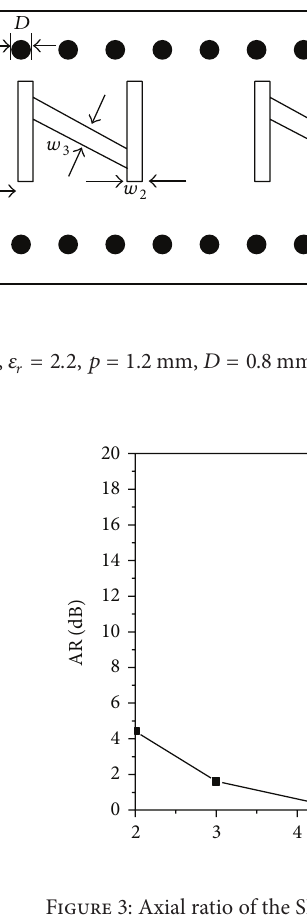
Figure 2: 𝑆 -parameters of the SIW leaky-wave antenna as functions of width of the N-shaped slot, 𝑓 = 8 GHz.